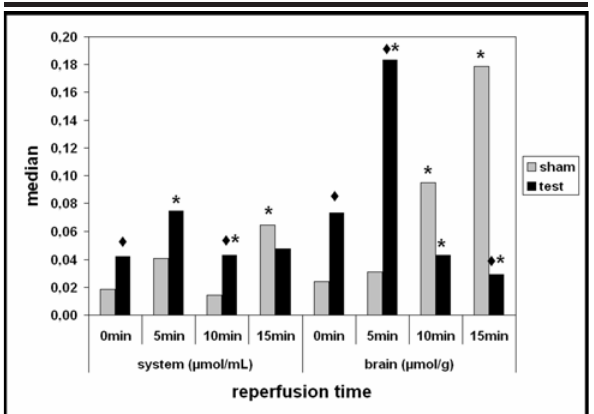
FIGURE 1 - Systemic and brain acetoacetate (ACT) concentrations in sham and test groups at different times of reperfusion. [ ♦ ] p<0.05 compared with respective sham group; [ * ] p<0.05 compared with similar previous group (Mann-Whitney U test)